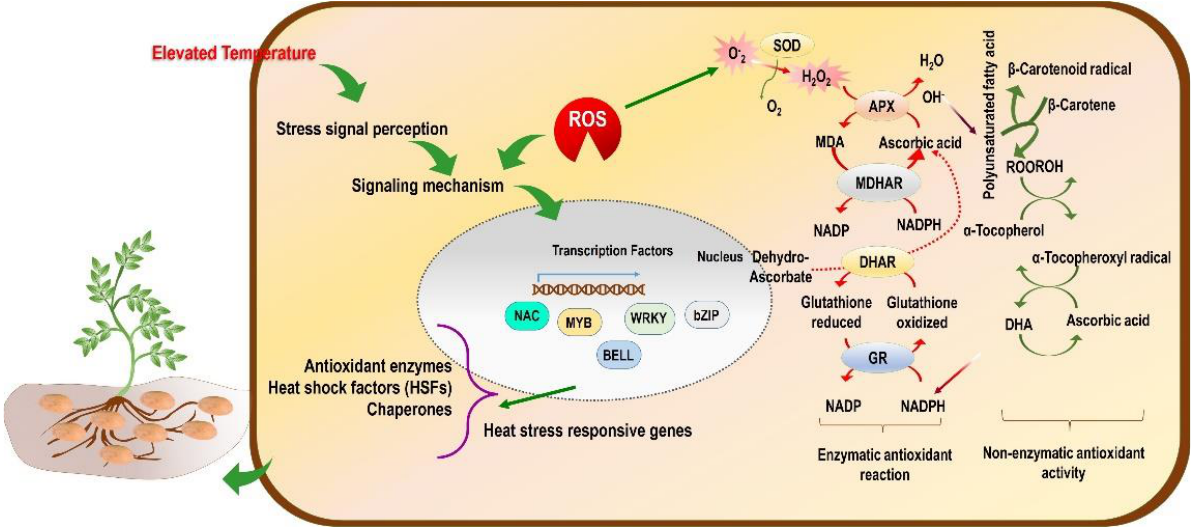
Figure 2. Conceptual model of the effect of high-temperature stress (tropicalization) on molecular mechanisms and ROS-mediated regulation of enzymatic and non-enzymatic antioxidant activity in potato plants.